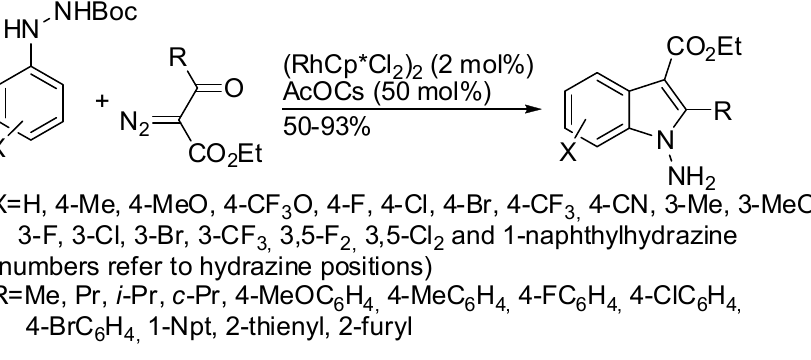
Scheme 55. Synthesis of unprotected